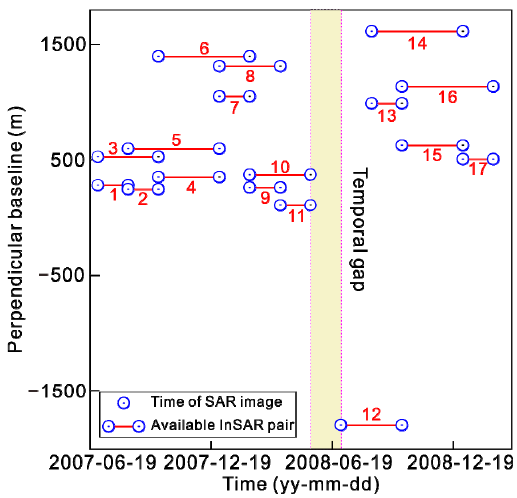
Figure 5. Temporal and perpendicular baselines of the available InSAR pairs.